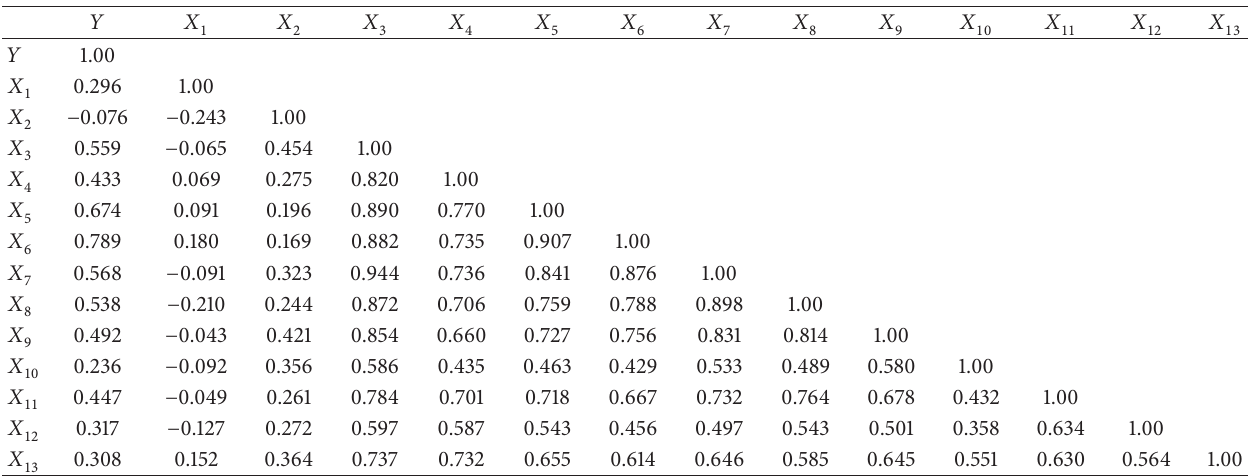
Table 2: Pearson correlations for pairs of variables.